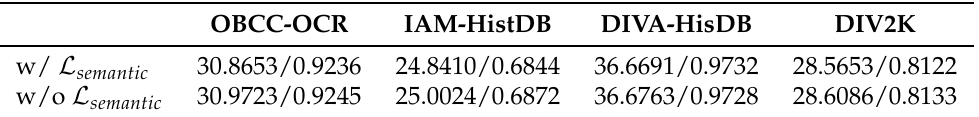
Figure 4. Visual comparison (case 2) of text SR images with and without the semantic loss between training using OBCC-OCR. The images are enlarged to improve visibility. The letters are better reconstructed by using semantic loss. Table 2. Quality improvement of SR images with the semantic loss when training using the non- text image dataset (DIV2K). The values to the left and right of ‘/’ represent the PSNR and SSIM,